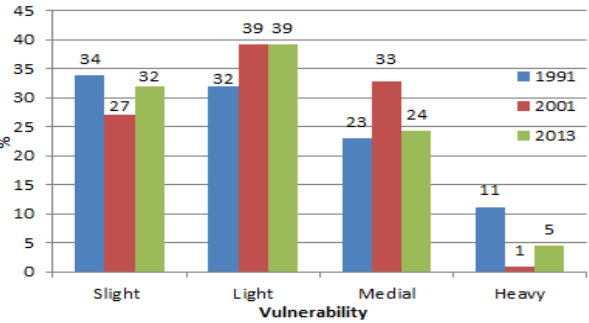
Figure 5 . Environmental vulnerability maps of the study